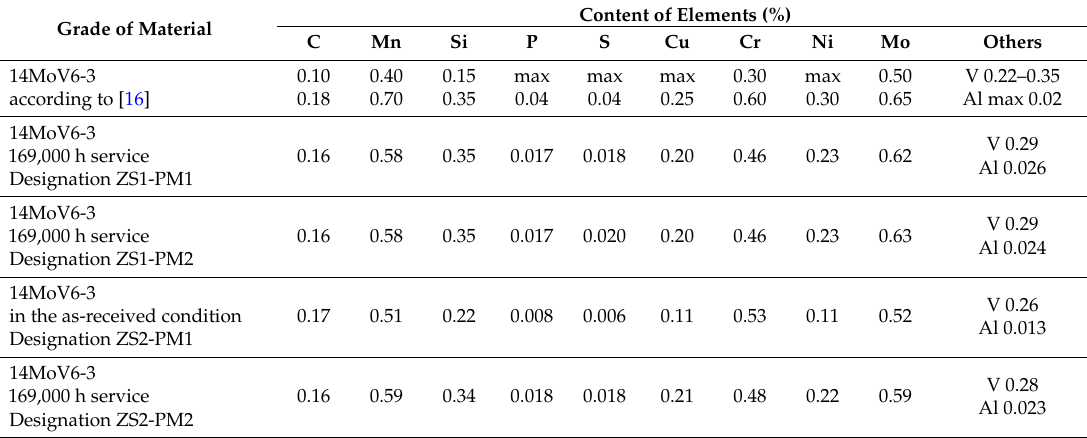
Table 2. Check analysis of chemical composition.